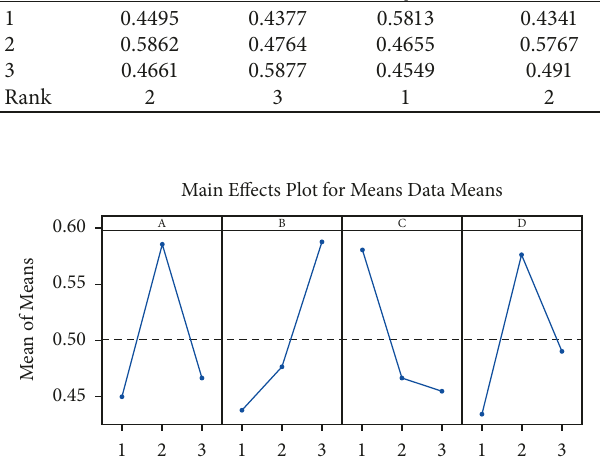
Figure 11: Main effects plot for means for zinc-coated brass